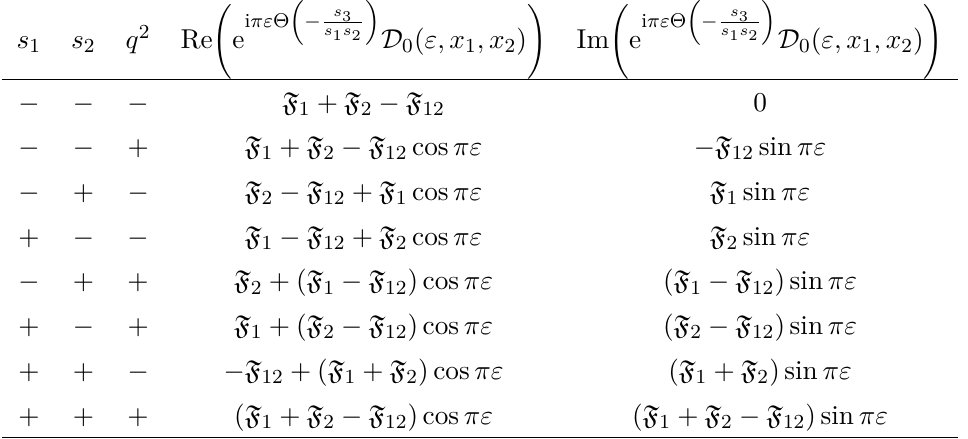
Table 1 . Real and imaginary part of e i πε Θ of s 1 , s 2 and q 2 . For compactness we introduce the abbreviations F 1 ≡ F ( ε ; x 1 ) , F 2 ≡ F ( ε ; x 2 ) and F 12 ≡ F ( ε ; x 1 + x 2 − x 1 x 2 )